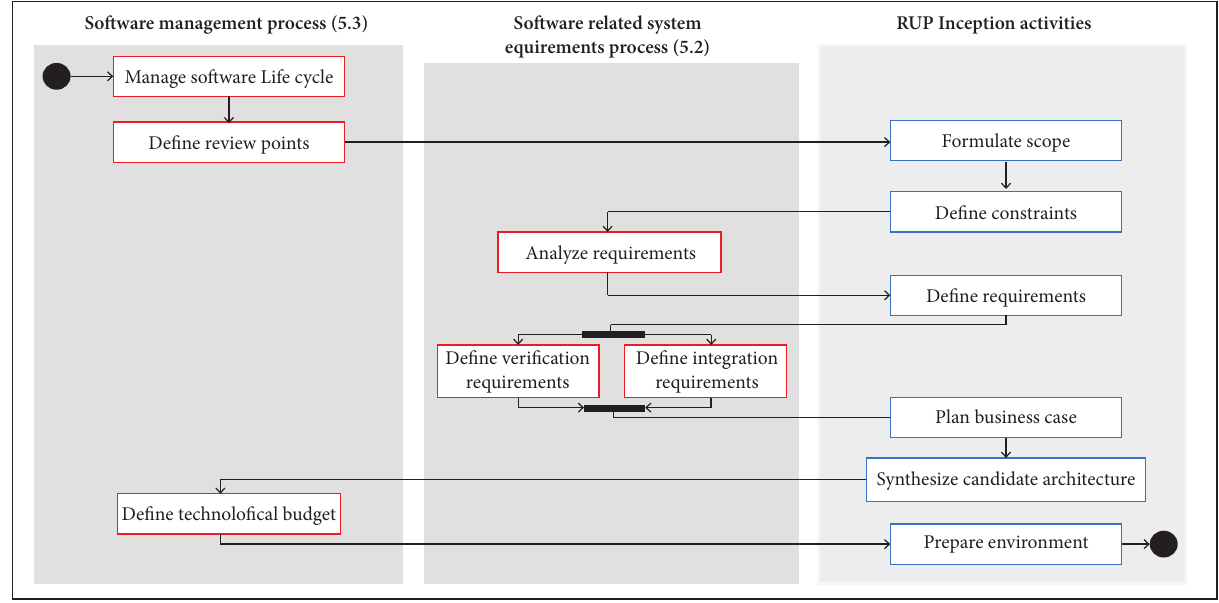
figure 7. Inception phase activities for the H4ASD. are executed, SW layers (business/logic, user interfaces and data) are integrated to obtain the fi rst version of the application, general functional tests are performed on the program, and, fi nally, the fi rst version of the SW manual is consolidated. Th e (5.8) process is executed in parallel for each iteration of coding, verifying the source code, soft ware versions and the fi nal product. Figure 9 shows the fl ow of activities for the H4ASD construction